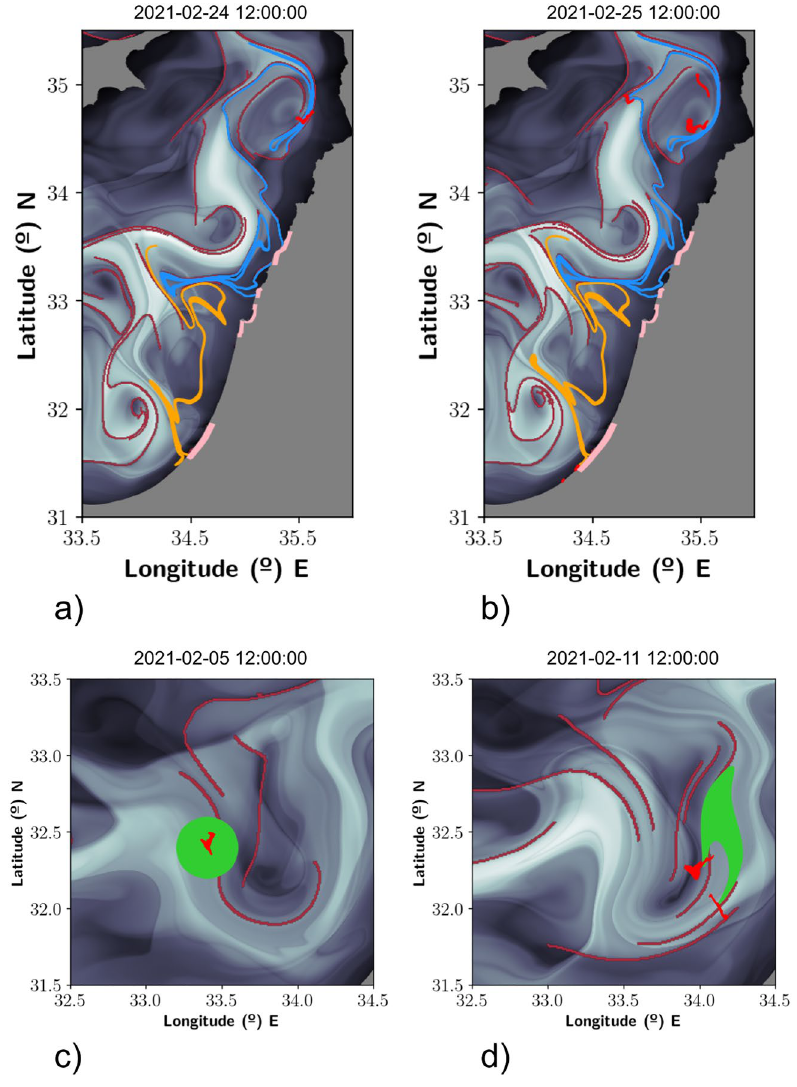
Figure 4. Simulations that connect successive oil spill observations. The function M at the background is represented at t 0 equal to the corresponding date. ( a ) Evolution on the 24th February 2021 and satellite observations; ( b ) evolution on the 25th February 2021 and satellite observations; ( c ) satellite observation on the 5th February 2021 and a 1st release attached to the observation; ( d ) evolution on the 11th February 2021 and satellite observations. These figures have been created with Python 3.9.2 (https:// www. python. org/ downl oads/ relea se/ python- 392/). The maps shown have been generated with a mask provided by OpenStreetMaps (https:// osmda ta. opens treet map. de/ data/ land- polyg ons.